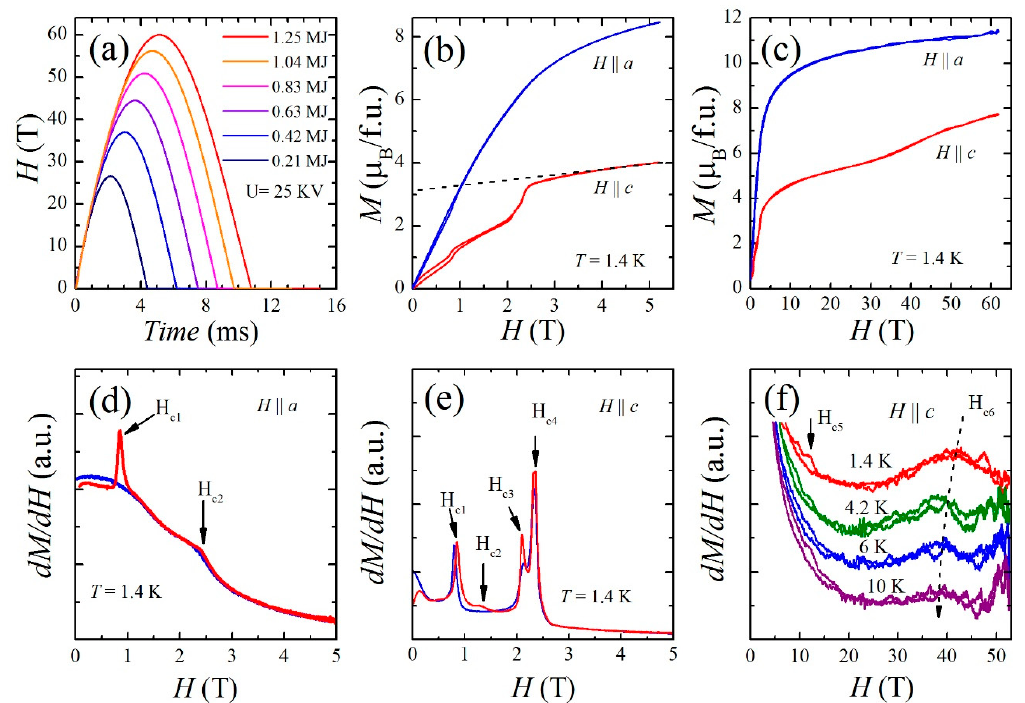
Figure 2. ( a ) Waveforms of pulsed fields driven by various capacitor banks. To generate an 11 ms / 62 T pulsed field, a 1.25 MJ capacitor bank with a discharge voltage 25 kV is applied. While the 0.21 MJ capacitor bank is used to generate a ~4 ms short-pulsed field. ( b ) Magnetization data measured at 1.4 K for H // a and H // c , respectively. The data were measured using a ~4 ms short-pulsed field. The dashed line shows linearly extrapolating the magnetization data to zero fields. ( c ) A comparison between the a - and c -axis magnetizations in fields up to 62 T. ( d , e ) The derivative d M / d H of the data in ( b ). The red (blue) curve denotes the field-increasing (-decreasing) process. ( f ) The derivative d M / d H of the data in ( c ). The arrows in ( d – f ) indicate the field-induced magnetic phase transitions.